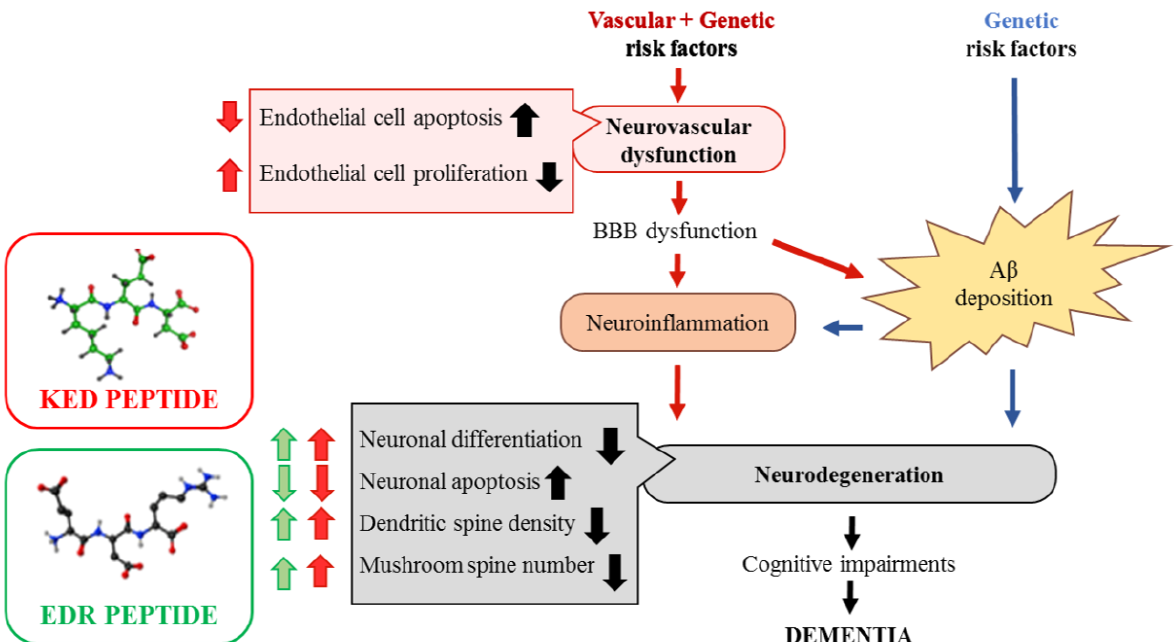
Figure 12. Proposed neuro-vasoprotective effects of the KED and EDR peptides in Alzheimer’s disease. Vascular factors (hypertension and diabetes) and/or genetic risk factors for AD, such as the ε4 allele of apolipoprotein E, can all lead to a neurovascular dysfunction in cerebral vessels. It leads to a blood–brain barrier (BBB) dysfunction and accumulation of blood-derived neurotoxic molecules in the brain, causing neuroinflammation. Additionally, within the amyloidogenic Aβ pathway, BBB dysfunction can disrupt Aβ clearance across the BBB and promote Aβ accumulation in the brain. These two ways can independently and/or synergistically lead to synaptic and neuronal dysfunction, neurodegeneration, cognitive impairments, which ultimately lead to dementia [76]. The EDR peptide improves neuronal differentiation, dendritic spine density and increases the number of mushroom spines, which are decreased in AD. The KED peptide provides decreased endothelial and neuronal cell apoptosis and increased endothelial cell proliferation, neuronal differentiation, dendritic spine density, and the number of mushroom spines in AD.